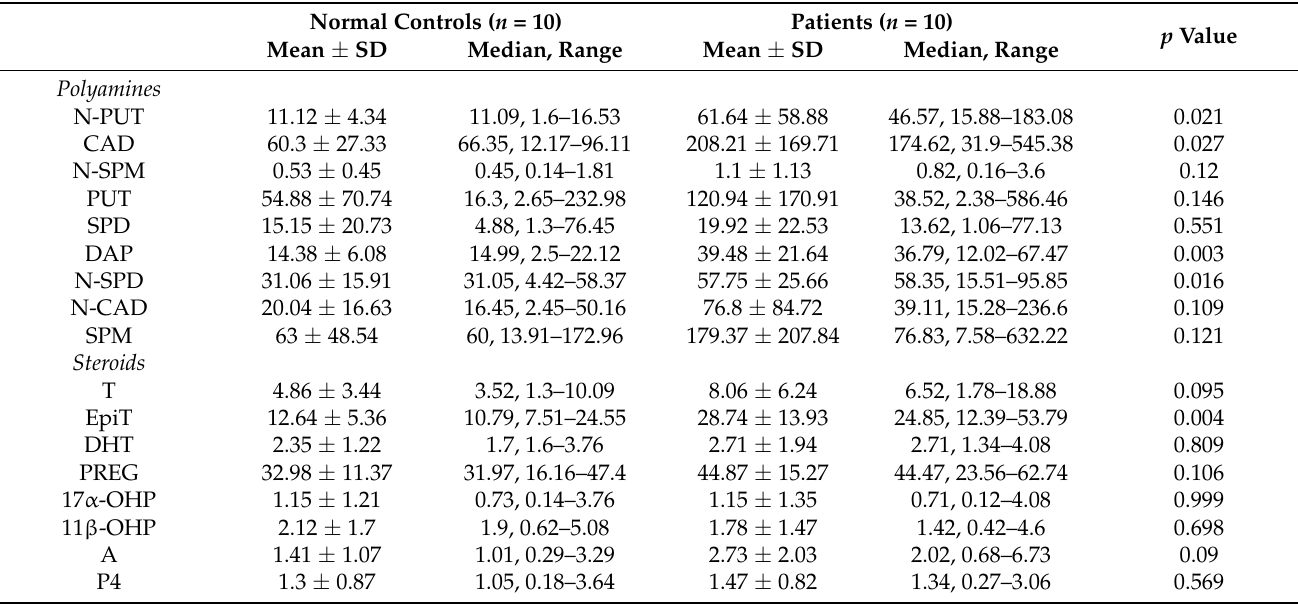
Table 3. Concentrations of nine polyamines and eight steroids in human serum samples of patients with breast cancer after treatment and normal controls (ng/mL).